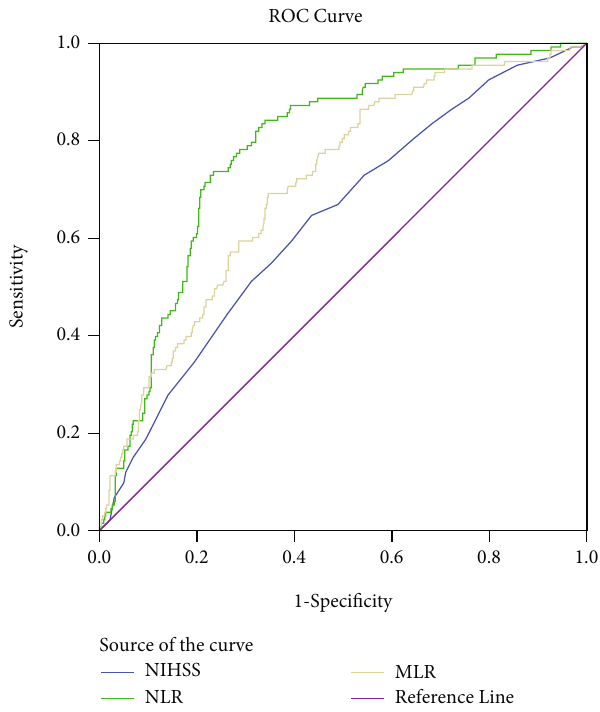
Figure 2: Receiver-operating characteristic curves for MLR, NLR, and NIHSS for predicting AKI. MLR: monocyte-to-lymphocyte ratio; NLR: neutrophil-to-lymphocyte ratio; PLR: platelet-to- lymphocyte